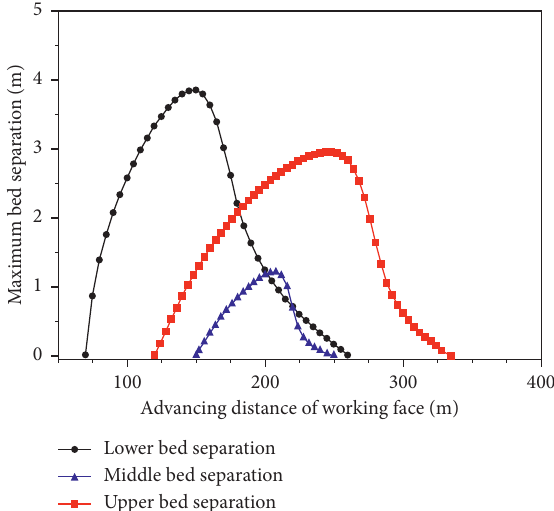
Figure 8: Maximum opening of bed separation versus the advancing distance of working face.